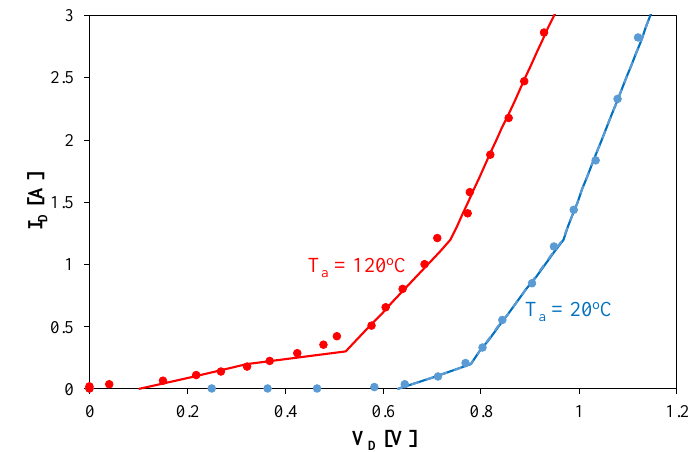
Figure 3. Characteristics of a forward-biased diode computed with the use of a piecewise linear model (lines) and measured (points) at selected values of temperature T a .